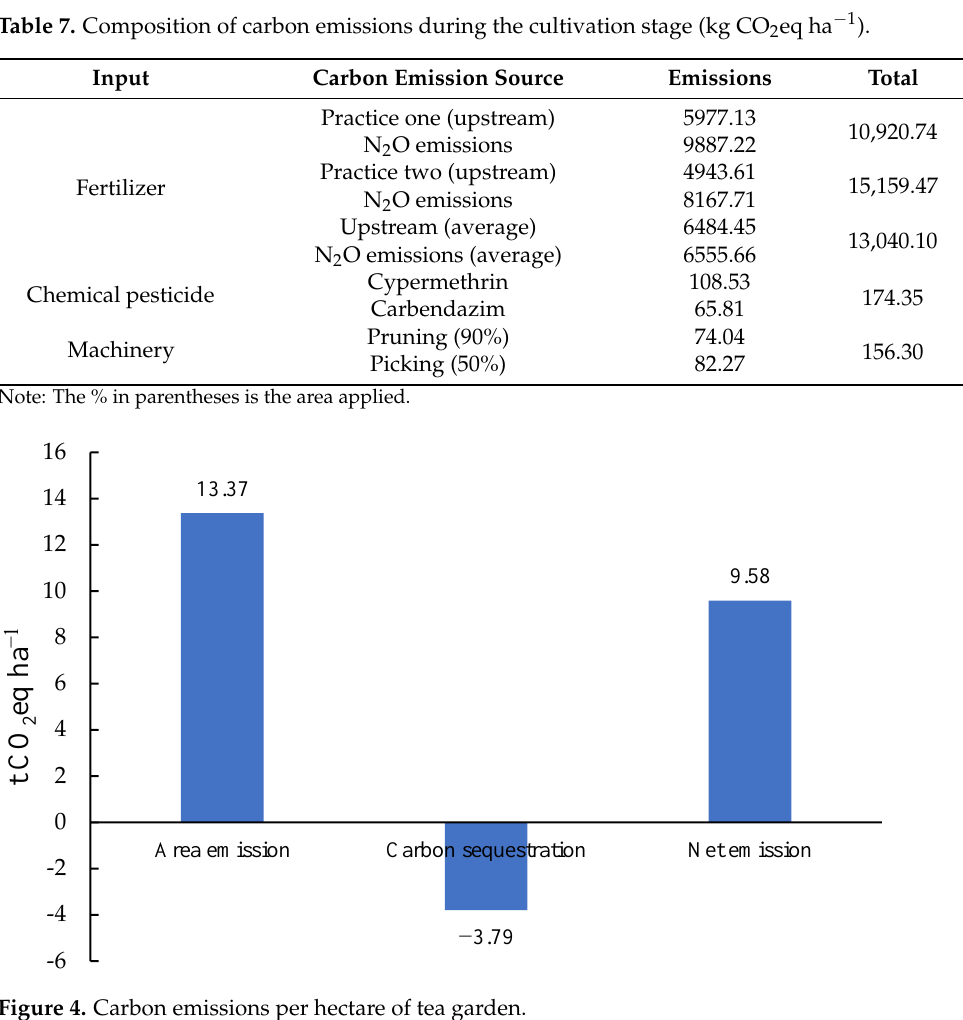
Figure 4. Carbon emissions per hectare of tea garden.